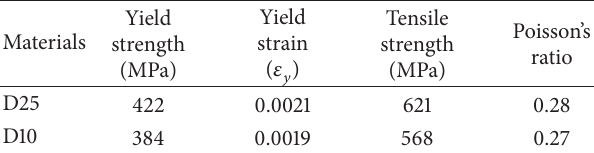
Table 2: Mechanical characteristics of